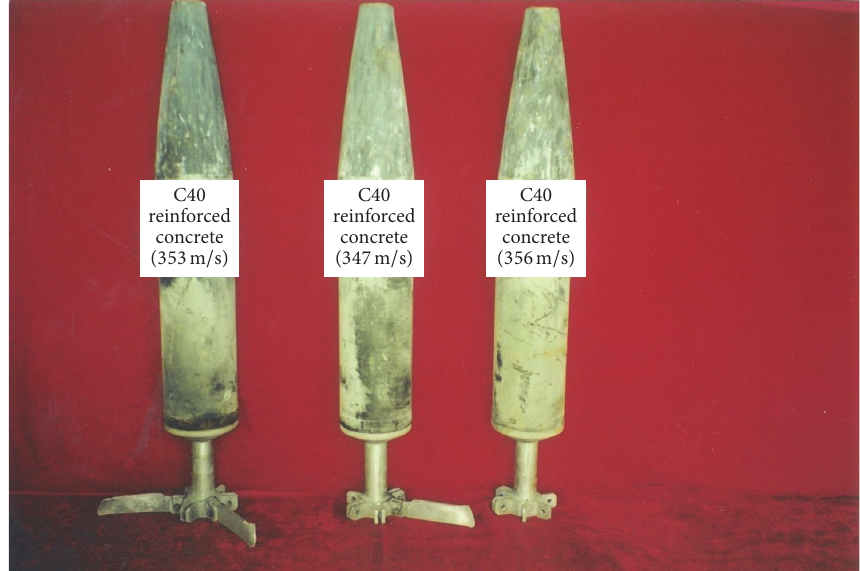
Figure 6: Damaged projectiles of reinforced concrete targets.